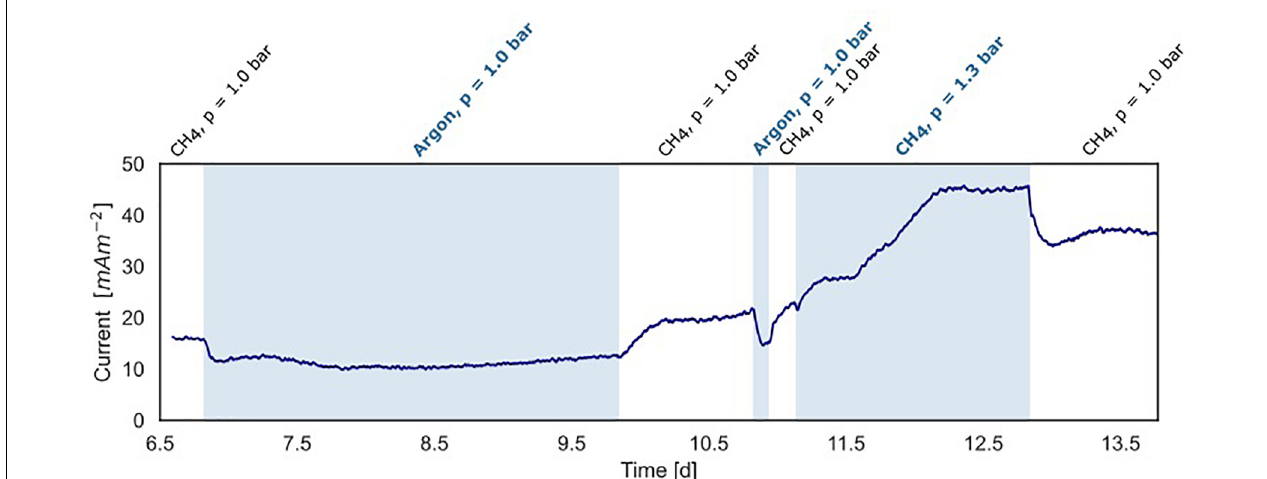
FIGURE 5 | Current production under varying methane concentrations in the BES headspace (experiment B). White areas show standard conditions at atmospheric pressure with CH 4 /CO 2 (95%/5%) and N 2 flushed through the anode chamber. The blue areas show non-standard conditions with-in the first and second part, argon/CO 2 flushed through the system at atmospheric pressure, replacing CH 4 /CO 2 . In the third part, the gas in- and outflow was interrupted and 30 ml CH 4 was added to the anode with a CH 4 /CO 2 (95%/5%) headspace resulting in an overpressure of 0.3 bar.